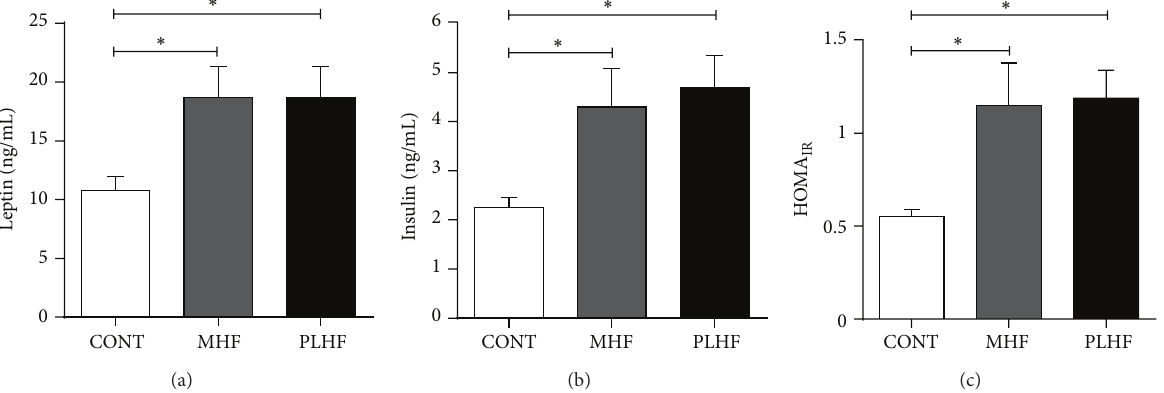
Figure 2: Fasting plasma leptin (a), insulin (b), and homeostatic model assessment (HOMA) to quantify insulin resistance and beta-cell function (c) in adult CONT, MHF, and PLHF offspring. Data are means ± SEM, 𝑛 = 10–18 per group. ∗ 𝑃 < 0.05 . Levels of mRNA of IRS2, PDX-1, and Kir6.2 were